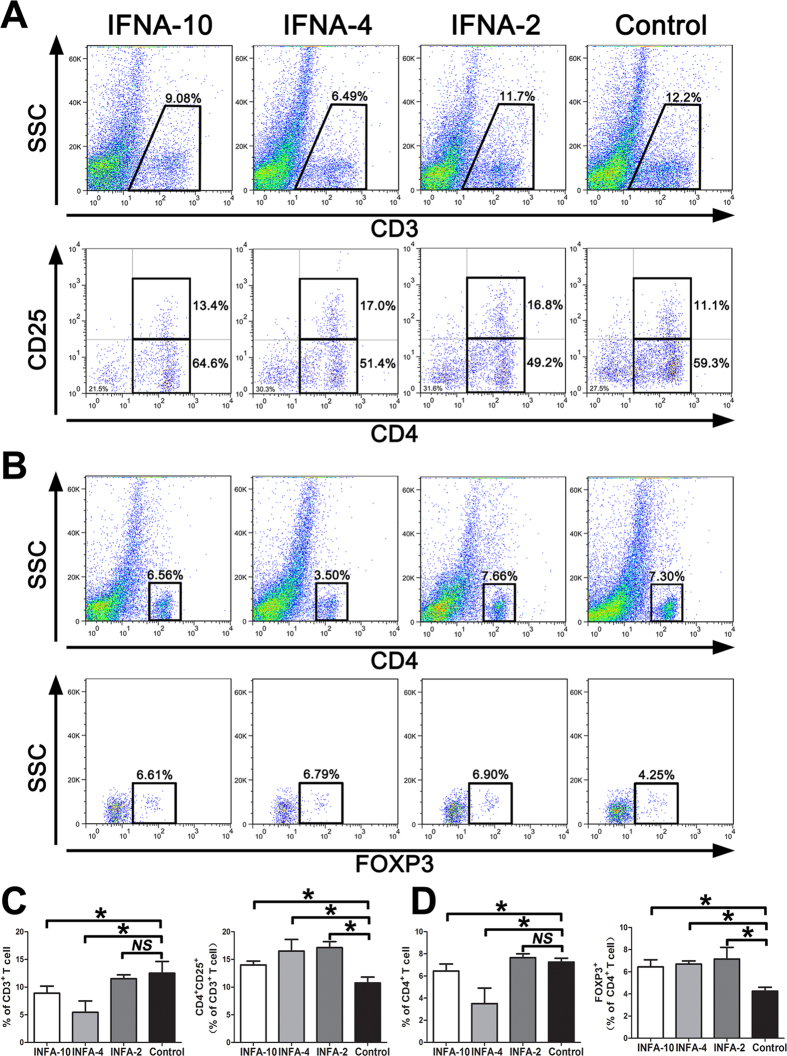
IFNA4 and IFNA10 inhibit acute colitis through induction of Treg cells. (A-B) FACS analysis of isolated cells from mice DSS-induce acute colitis groups, upper panels indicate first gate of lower panels. (C-D) Quantification analysis of upper FACS results, as CD4+ CD25+ cells in CD3+ and Foxp3+ cells in CD4+ T cells in the colon tissues, 5 mice in each group and analyzed the samples in triplicate, bars represent the mean ± SD.